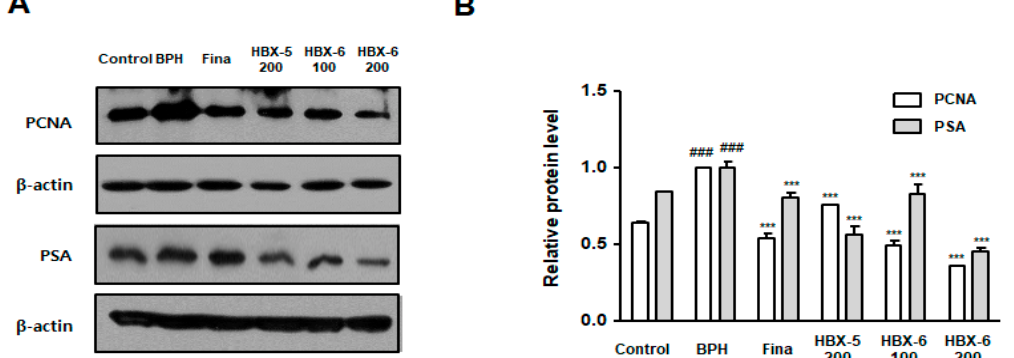
Figure 7. Effect of HBX-6 on proliferation-relative protein expression in prostate tissues of mice with BPH. The levels of PCNA and PSA were analyzed by a Western blot analysis. Values were presented as mean ± SD ( n = 10); ### p < 0.001 versus control group; *** p < 0.001 versus BPH group. ANOVA and Dunnett’s post hoc test were used for significances between each experimental group.